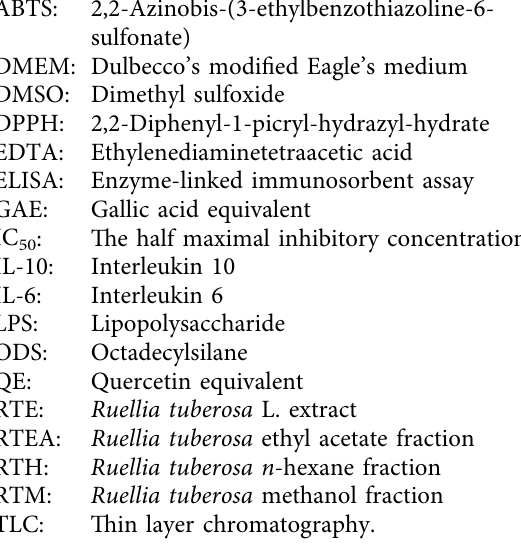
Figure S1: 1 H NMR spectrum of compound 1. Figure S2: 13 C NMR spectrum of compound 1 . Figure S3: 1 H NMR spectrum of compound 2. Figure S4: 13 C NMR spectrum of compound 2 . Figure S5: 1 H NMR spectrum of compound 3. Figure S6: 13 C NMR spectrum of compound 3. Figure S7: 1 H NMR spectrum of compound 4. Figure S8: 13 C NMR spectrum of compound 4. Figure S9: 1 H NMR spectrum of compound 5. Figure S10: 13 C NMR spectrum of compound 5. Figure S11: 1 H NMR spectrum of compound 6. Figure S12: 13 C NMR spectrum of compound 6. Figure S13: 1 H NMR spectrum of compound 7. Figure S14: 13 C NMR spectrum of compound 7. Figure S15: 1 H NMR spectrum of compound 8. Figure S16: 13 C NMR spectrum of